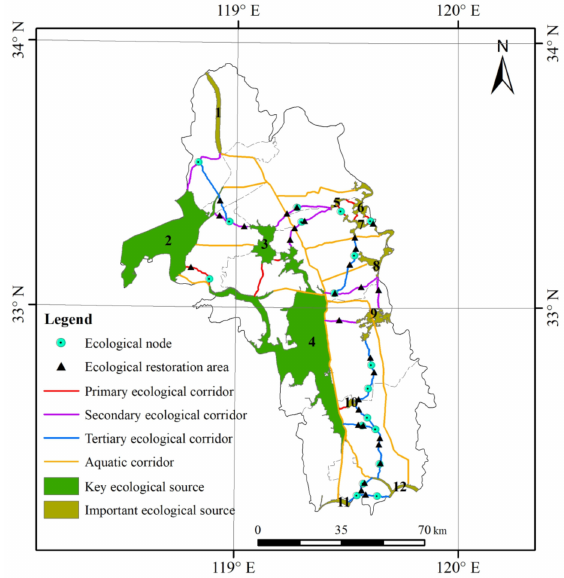
Figure 10. Spatial distribution of the ecological network after